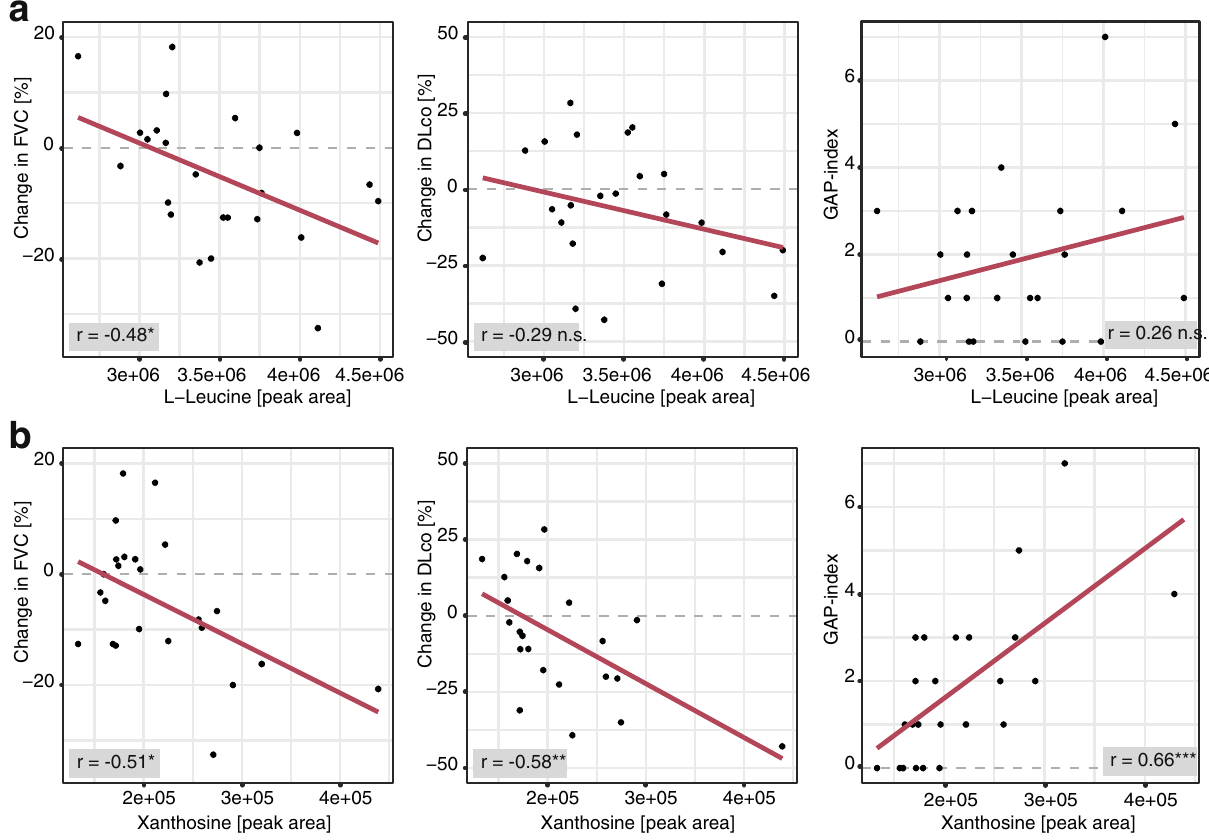
Figure 6. Pearson correlation analysis of l-leucine ( a ) and xanthosine ( b ) in SSc-ILD patients (n = 24). *p ≤ 0.05, **p ≤ 0.01, n.s. = p >